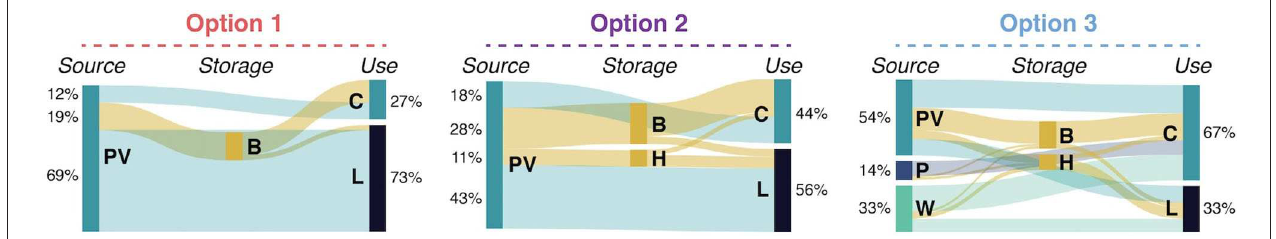
FIGURE 2 | Summary of the annual energy fluxes between energy sources, storage systems and uses. Energy sources include photovoltaic ( PV ), wind turbines ( W ) and pyrolysis ( P ); storage systems include lithium-ion batteries ( B ) and hydrogen-based storage ( H ); and uses include consumption ( C ) and losses ( L ).